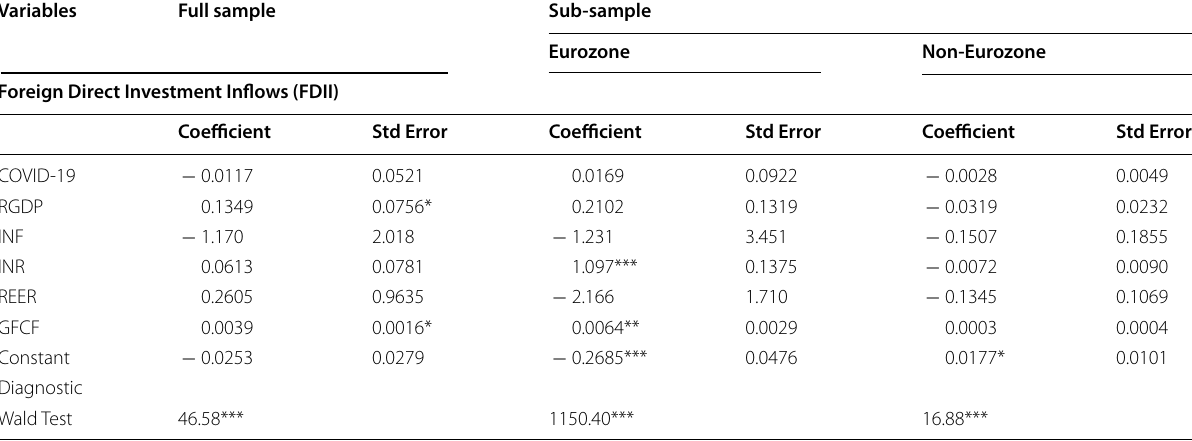
*** , **, and * represent the significance of the unit root model at the 1, 5, and 10% levels